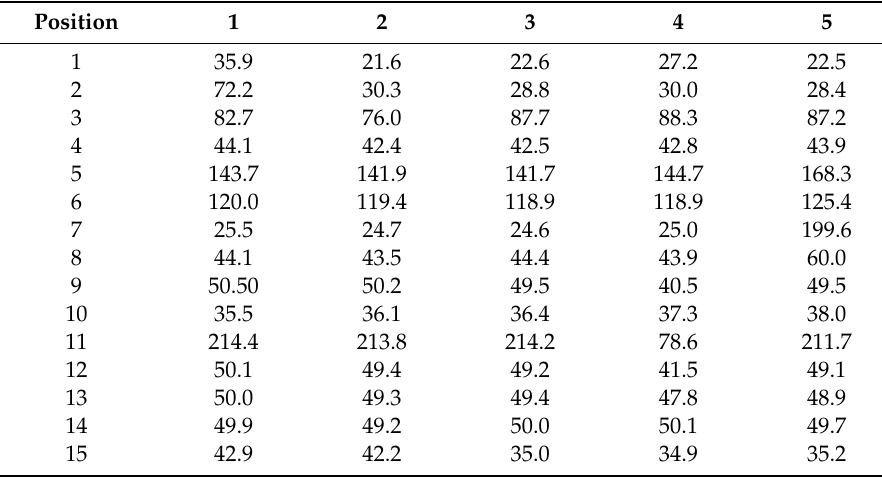
Table 2. 13 C-NMR (150MHz, pyridine- d 5 ) spectral data of compounds 1 – 5